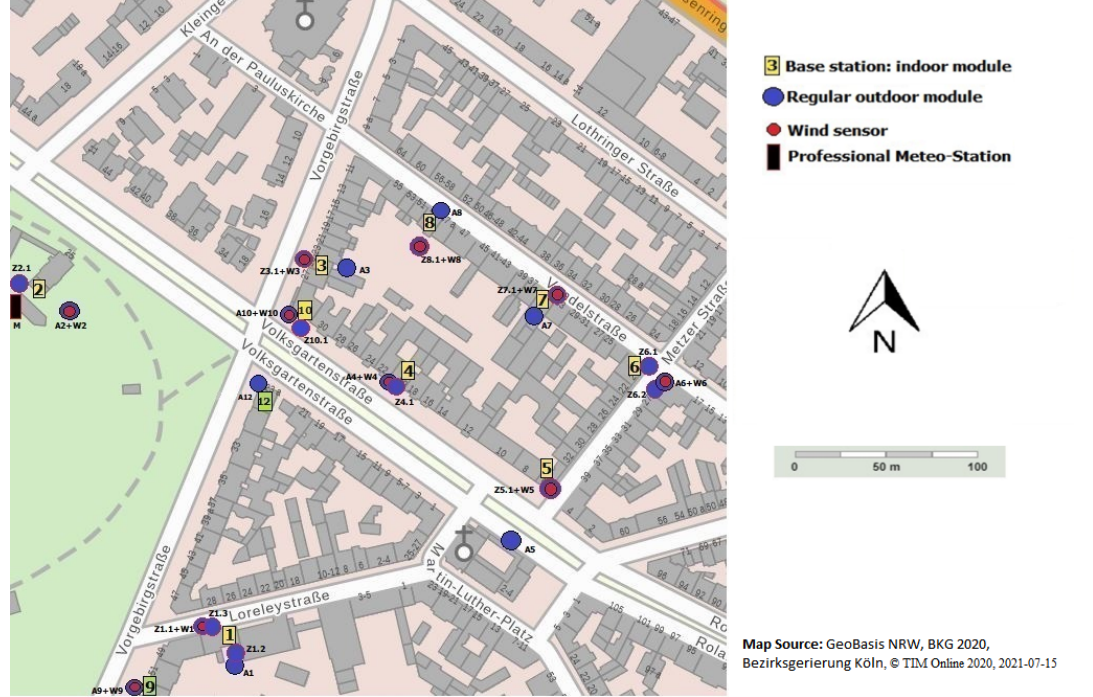
Figure 2. Built up weather station network in the urban study area in Cologne: Locations of the 33 installed NETATMO sensors (tempera- ture/humidity sensors and wind sensors) and the research grade meteorological station (map: © TIM Online 2020).